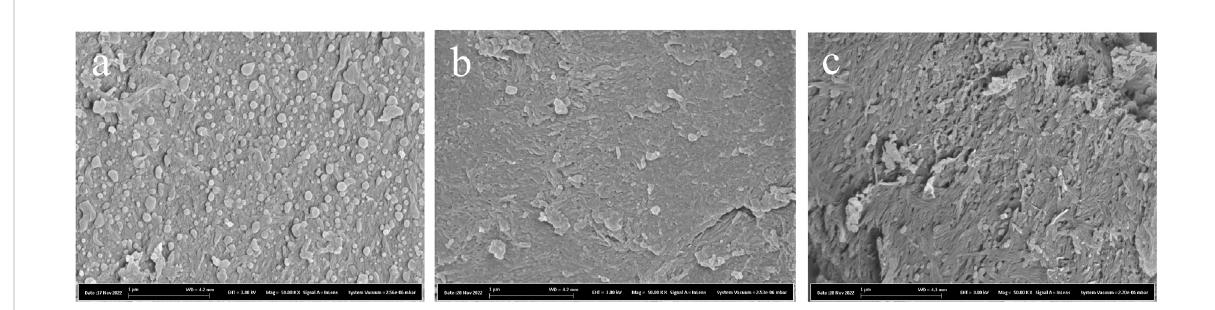
FIGURE 2 SEM micrographs of washed pretreated solids prior to enzymatic sacchari fi cation reactions (A) , and after 72 h of enzymatic sacchari fi cation in reactions supplemented with (B) air and (C) N 2 . The scale bar length is 1 µm.